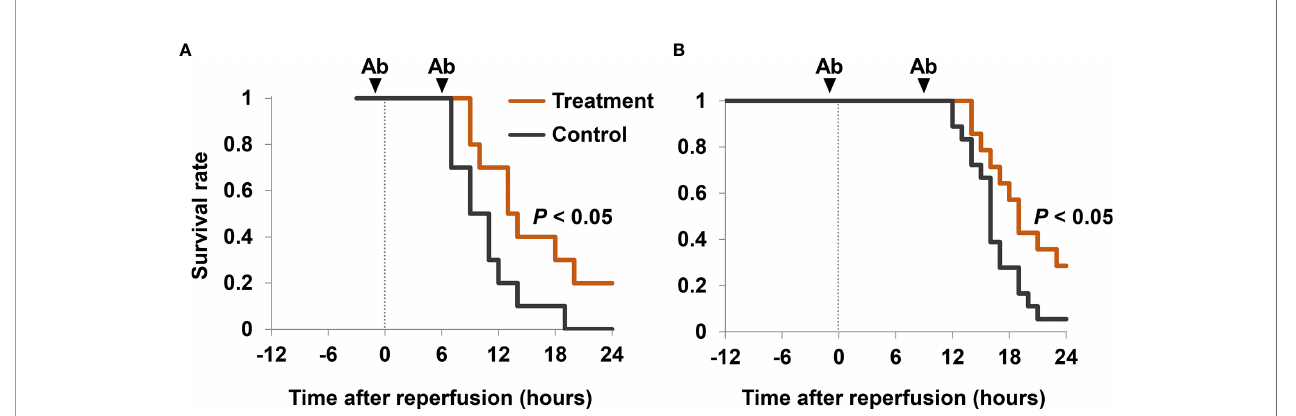
FIGURE 4 | Survival rates after I/R in mice treated with anti-HMGB1 and anti-histone H3 antibodies. (A) Mice with 3 h I/R injury were treated with 2.5 mg/kg of anti- HMGB1 antibodies ( n = 10) or non-speci fi c control antibodies ( n = 10) twice, at 1 h before reperfusion and 6 h after reperfusion. (B) Mice with 12 h I/R injury were treated with 2.5 mg/kg of anti-HMGB1 and anti-histone H3 antibodies ( n = 14) or non-speci fi c control antibodies ( n = 18) twice, at 1 h before and 9 h after reperfusion. Mice also received a subcutaneous injection of 20 mL/kg of normal saline 1 h before reperfusion. Survival curves were calculated using the Kaplan – Meier method. Survival rates were compared using a log-rank test. Cumulative data of two independent experiments are shown. Ab,